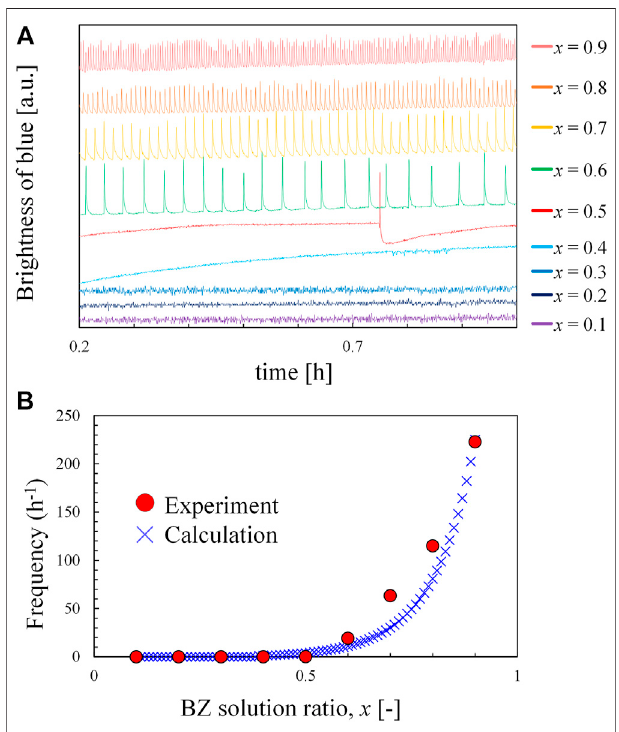
FIGURE 4 | Behavior of the mixture of BZ solution and ferroin solution in a batch reactor; (A) time developments of the blue brightness of the mixture with BZ solution ratio, x and (B) oscillation frequency of mixture as a function of x